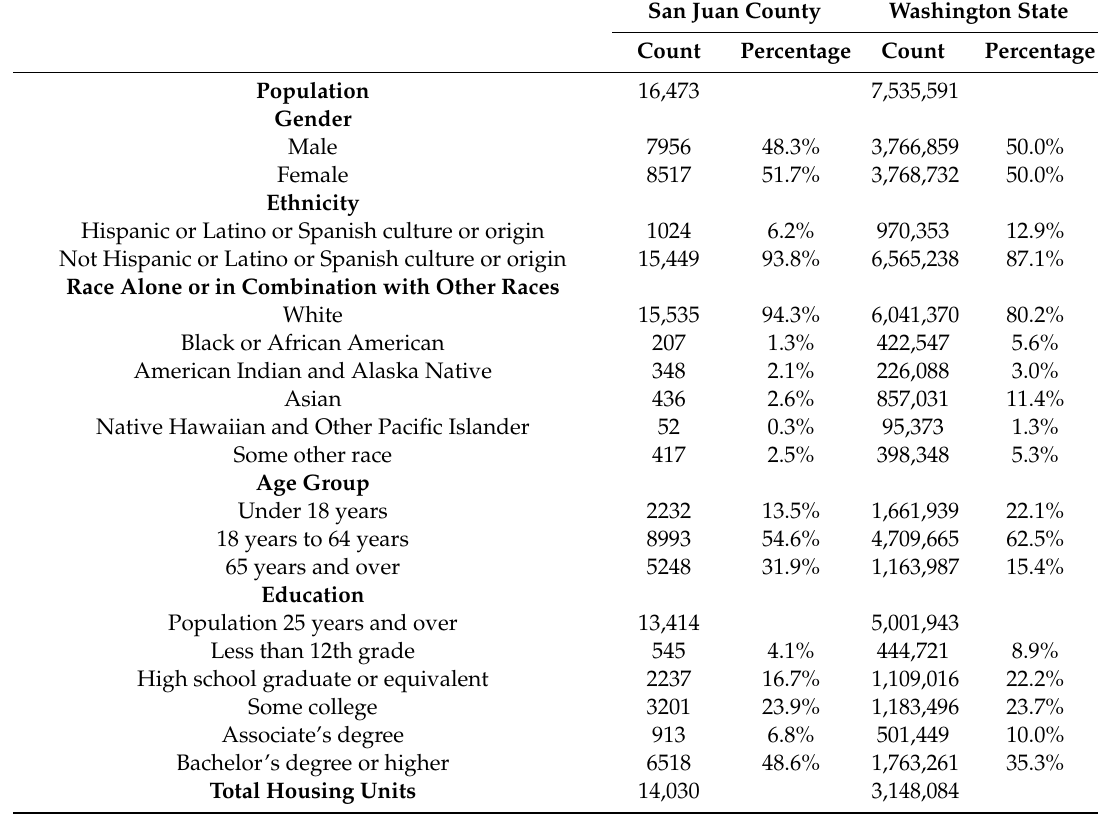
Table 1. Demographic characteristics of San Juan County and the State of Washington.